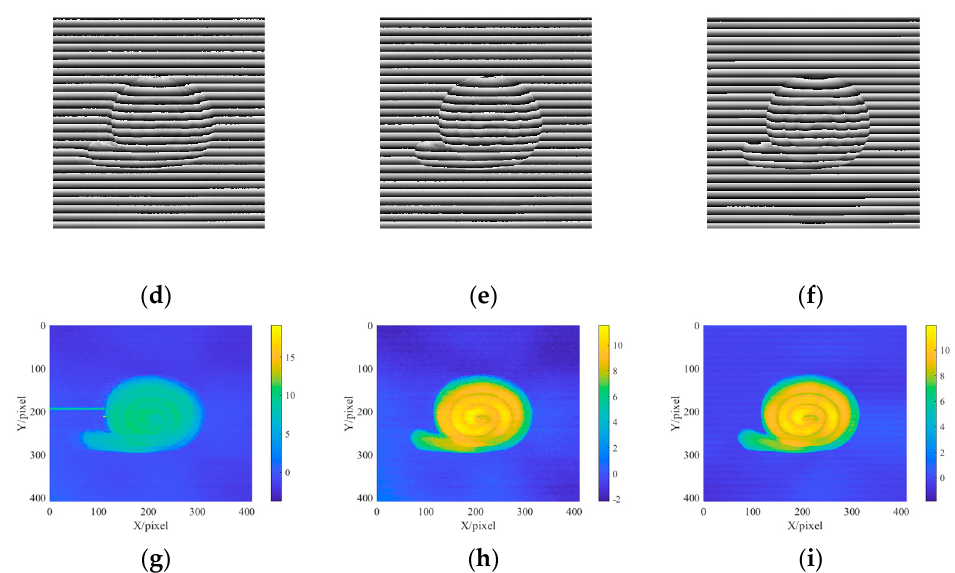
Figure 8. Experimental data and the comparison experiment results of the ‘’snail” model: ( a ) High-resolution deformed pattern by averaging; ( b ) High-resolution deformed pattern by the proposed method; ( c ) High-resolution deformed pattern by 8-step PMP; ( d ) Wrapped phase by averaging; ( e ) Wrapped phase by the proposed method; ( f ) Wrapped phase by 8-step PMP; ( g ) Reconstruction by averaging; ( h ) Reconstruction by the proposed method; ( i ) Reconstruction by 8-step PMP.